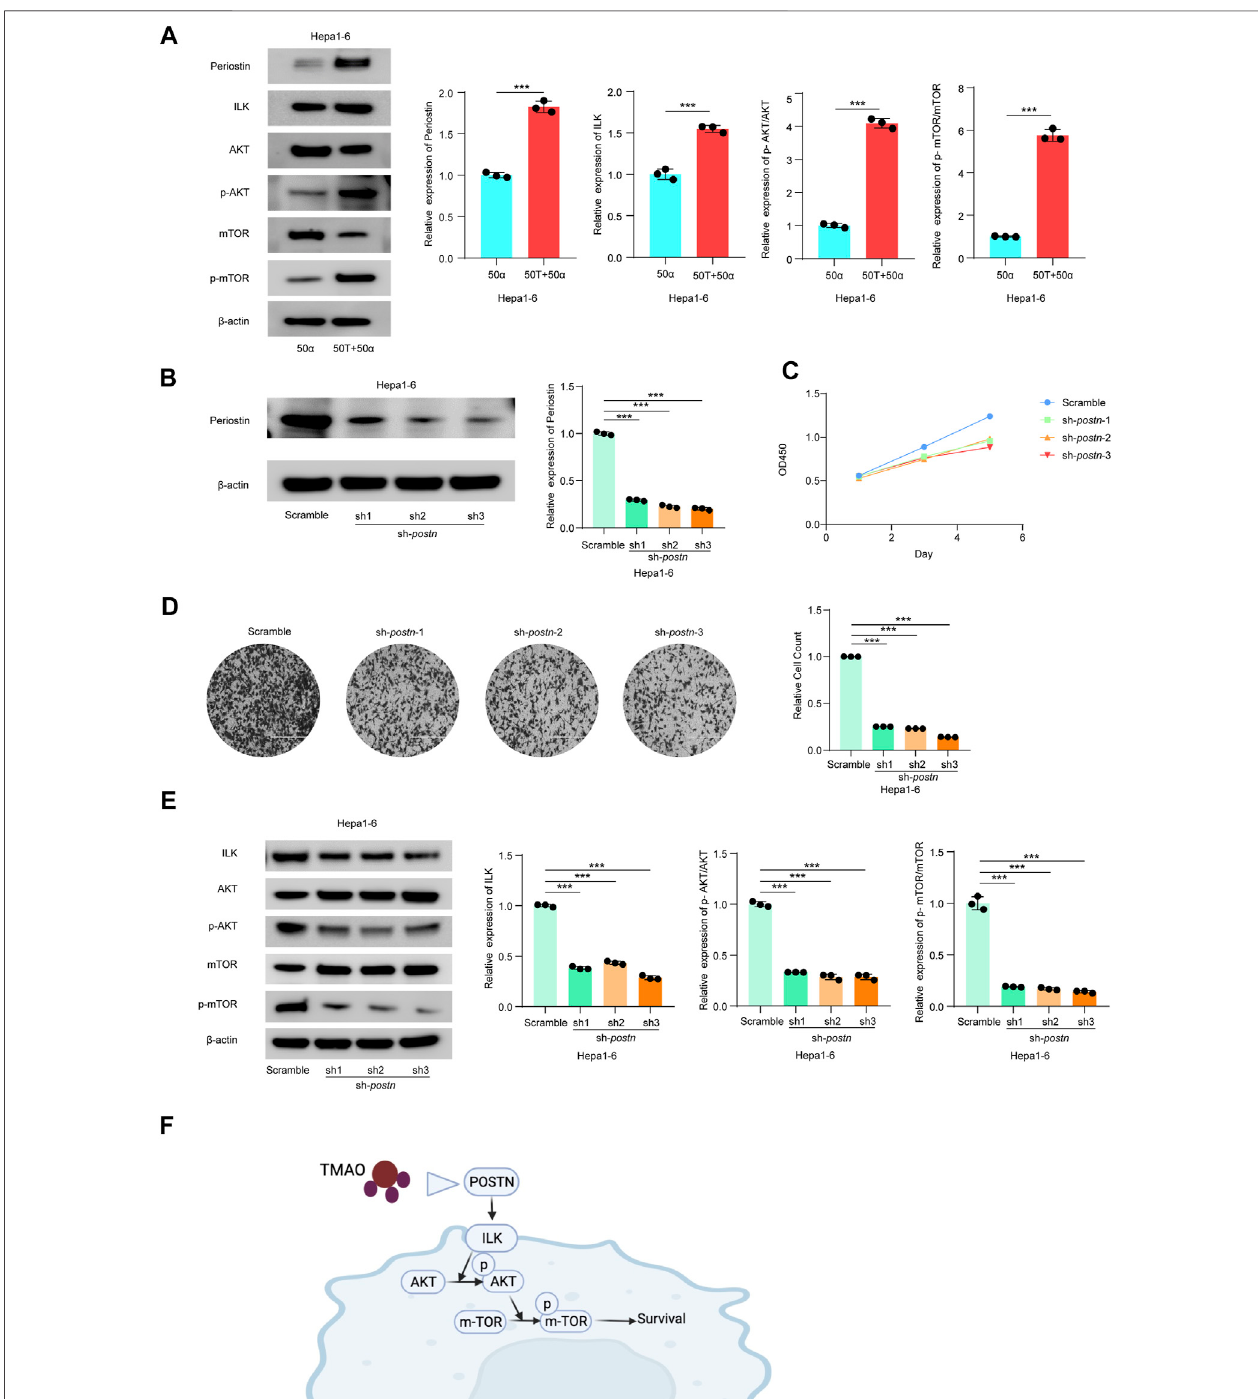
FIGURE 7 | TMAO activates ILK/AKT/mTOR signaling via Postn in Hepa1-6 cells. (A) The translation levels of POSTN, ILK, AKT, p-AKT, mTOR and p-mTOR measuredbywesternblottinginHepa1-6 treatedwith50 ng/mlTNF- α combined with50 μ MTMAOor50 ng/mlTNF- α alone.Grayscalevalueswereanalyzed;dataare mean±SD( n =3pergroup);Student ’ st-test;***, p < 0.001. (B) POSTNtranslationlevelsinHepa1-6cellsinfectedwithpseudovirusexpressingsh- postn (sh1,sh2,sh3) plasmids were compared with the Hepa1-6 cells infected with pseudovirus expressing scramble plasmids measured by western blotting. Grayscale values were analyzed; data are mean ± SD ( n = 3 per group); one-way ANOVA with Bonferroni ’ s test; ***, p < 0.001. (C) CCK-8 assay of the effect of knocking down Postn on the proliferationofHepa1-6cells;dataaremean±SD( n =3pergroup);one-wayANOVAwithBonferroni ’ stest;***, p < 0.001. (D)